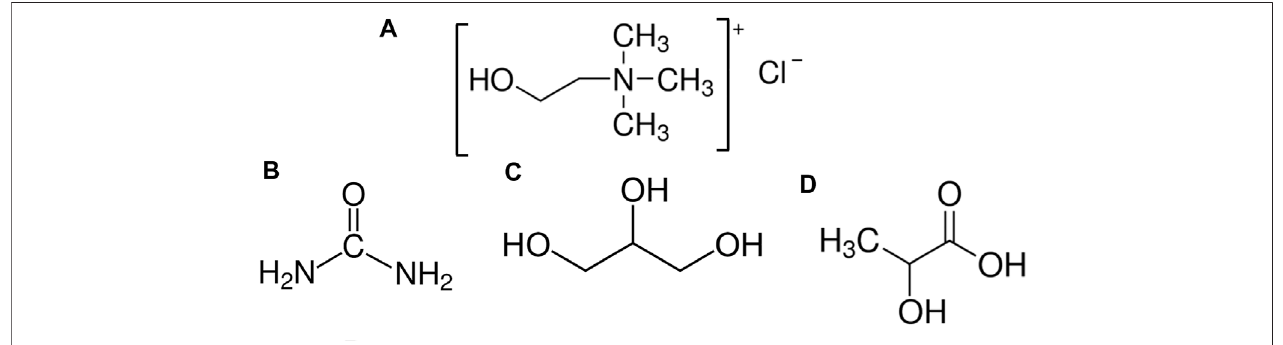
FIGURE 1 | Schematic representation of DES components: (A) Choline chloride (ChCl); (B) Urea; (C) Glycerol; (D) Lactic acid.